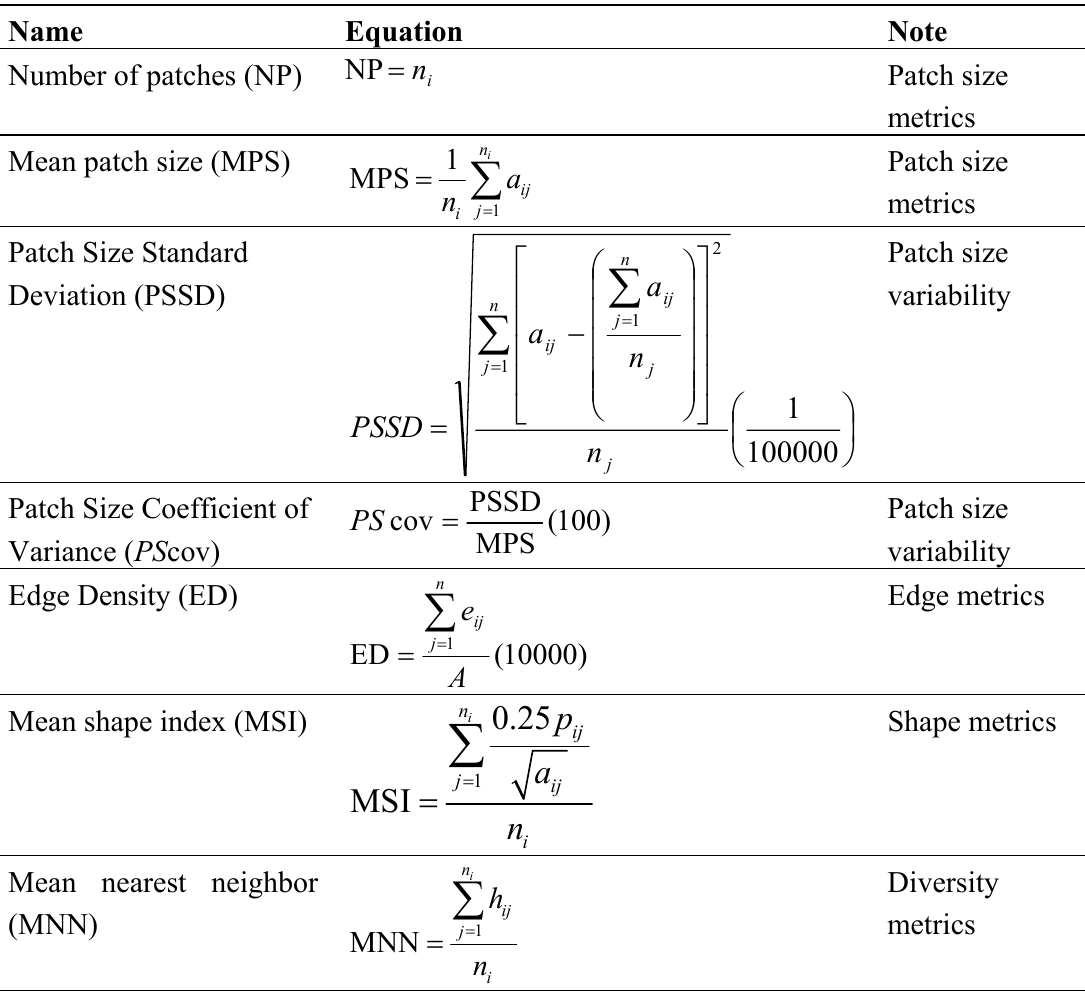
Table 1. Landscape